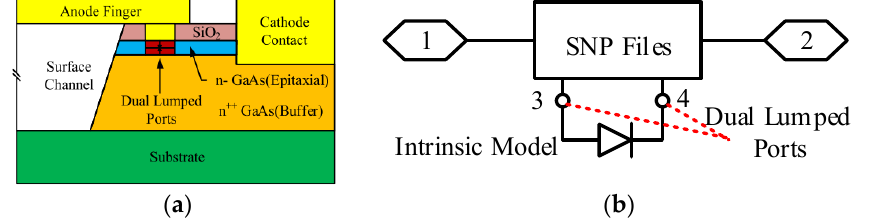
Figure 7. DLPT and diode embedding method [36]: ( a ) cross-sectional view of DLPT (red rectangle sheets represent lumped ports with integrated line pointing to each other); ( b ) 3-D EM model of diode based on DLPT (ports 3 and 4 represent dual lumped ports).